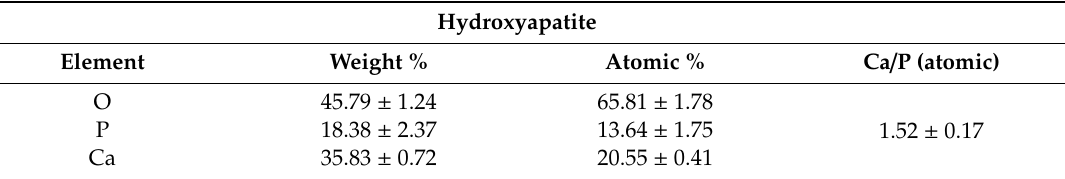
Table 3. Weight and atomic composition of used hydroxyapatite.